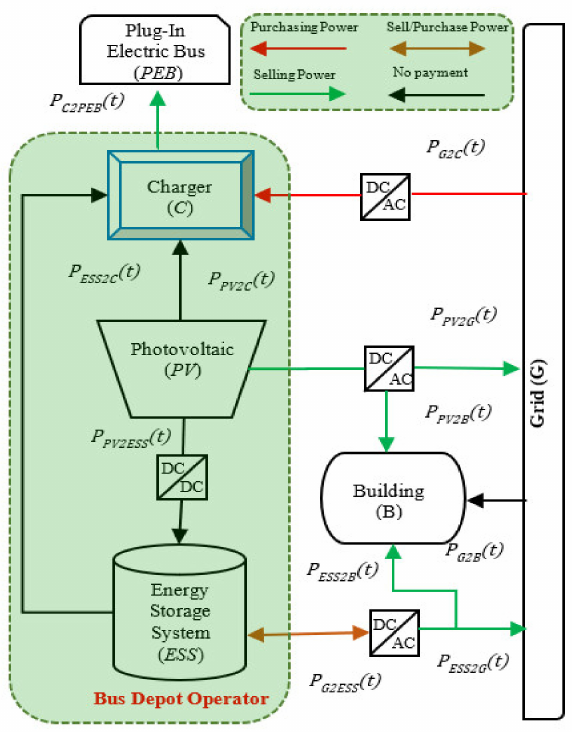
Figure 2. Bus depot charging